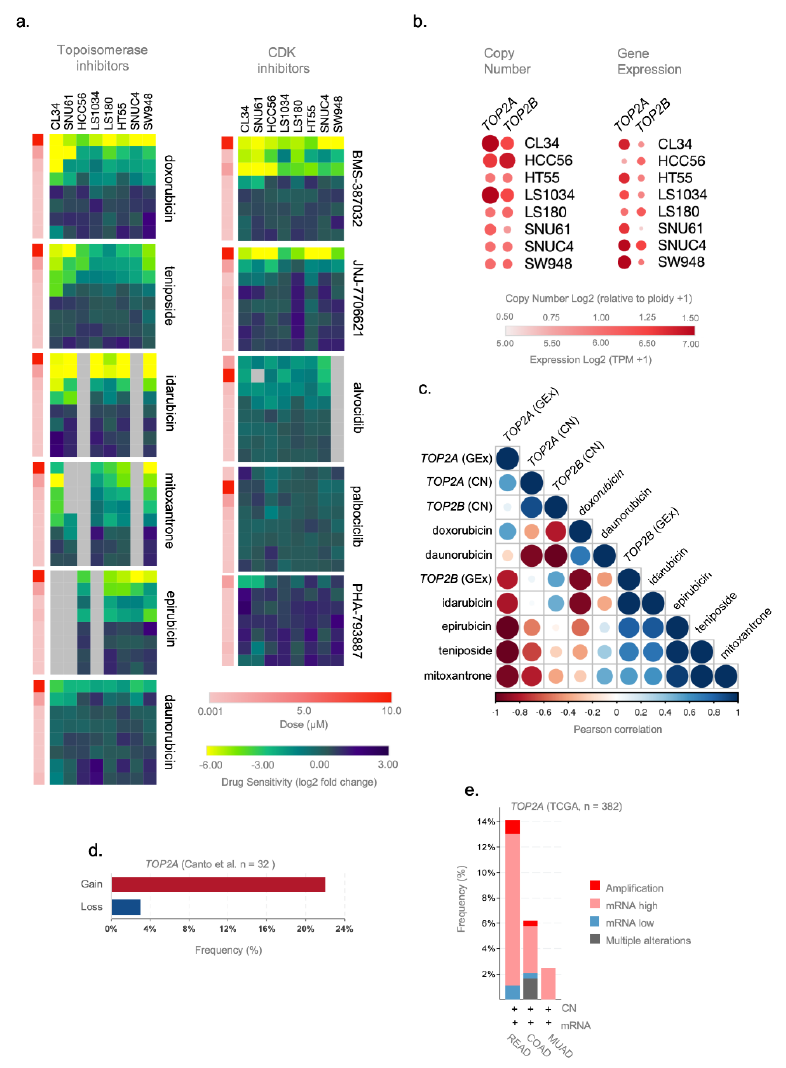
Figure 4. TOP2A gene expression and copy number are potential predictive markers of the efficacy of topoisomerase inhibitors in rectal cancer (ReCa). ( a ) Heatmaps of sensitivity (log2 fold change) for Topoisomerase and cyclin-dependent kinase (CDK) inhibitors in eight colorectal cancer (CRC) cell lines to validate the predictions using the PRISM Repurposing Secondary 19Q4 Screen [27,58]. The data were obtained in CRC cell lines with transcriptomic profiles similar to rectal tumor samples (Figure S8) and were downloaded from the Cancer Dependency DepMap; https://depmap.org/) (ac- cess on 11 June 2021) [58]. Columns (cells) and rows (drugs) for each compound were clustered based on the Euclidean distance of the log2 fold change values. The drug dose is represented in color bars and increases from light (0.001 μ M) to dark red (10.0 μ M). ( b ) Relative expression (TPM+1) and gene copy number [log2 (relative to ploidy +1)] of TOP2A and TOP2B in eight CRC cell lines from CCLE [31,32] database. The data (Copy Number 21Q2 Public and Expression 21Q2 Public da- tasets) were obtained in CRC cell lines with transcriptomic profiles highly correlated with rectal tumor samples (Figure S8) and downloaded from DepMap [58]. ( c ) Pearson correlation plot show- ing a negative correlation between TOP2A and TOP2B copy number and gene expression (Copy Number 21Q2 Public and Expression 21Q2 Public datasets) and drug sensitivity of topoisomerase inhibitors (doxorubicin, daunorubicin, idarubicin, epirubicin, teniposide, and mitoxantrone) (PRISM Repurposing Secondary 19Q4 Screen) in CRC cell lines (CL34, HCC56, HT55, LS1034, LS180, SNU61, SNUC4, and SW948). These colorectal cell lines present transcriptomic profiles